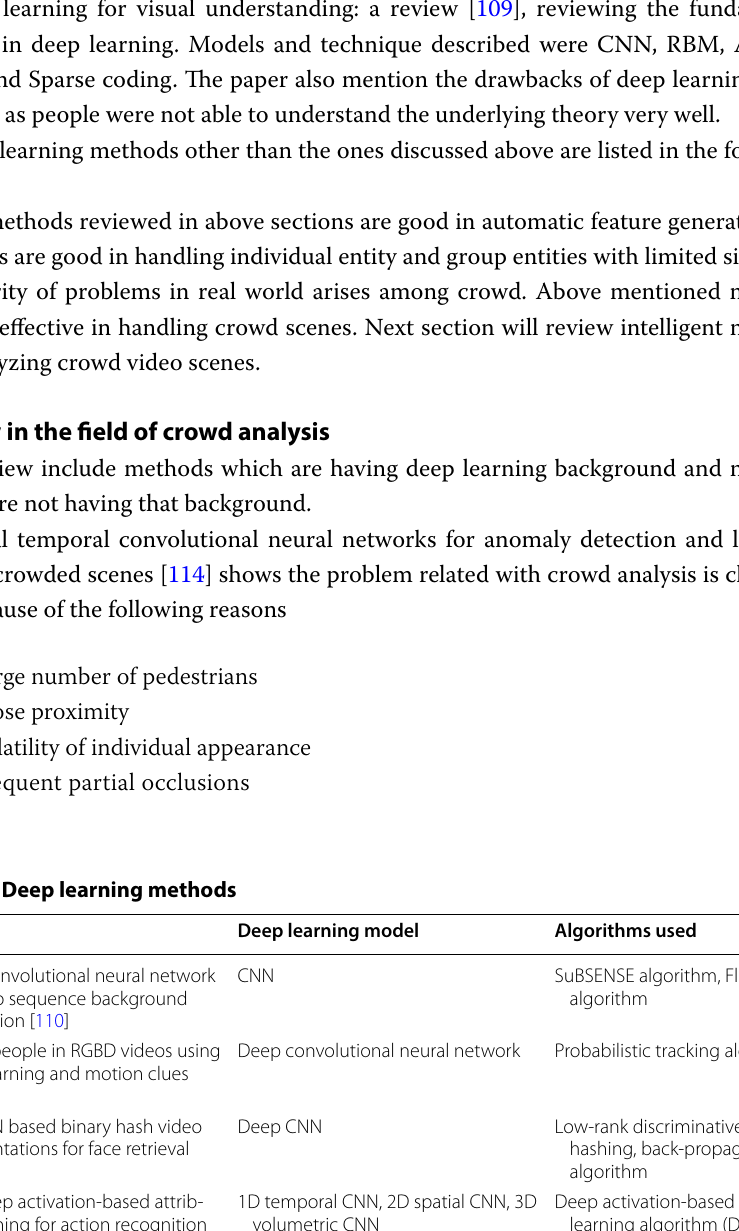
algorithm algorithm